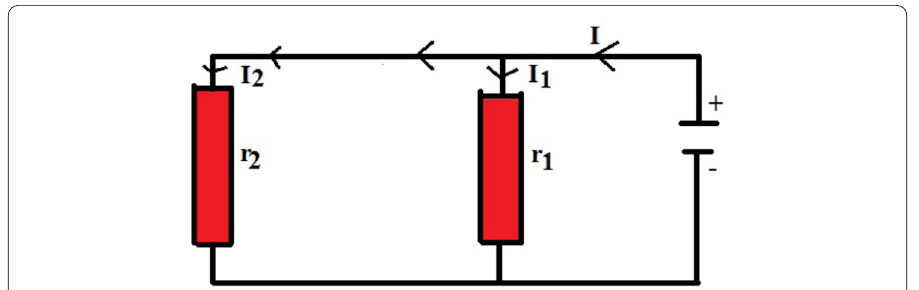
Figure 5 Parallel circuit with two